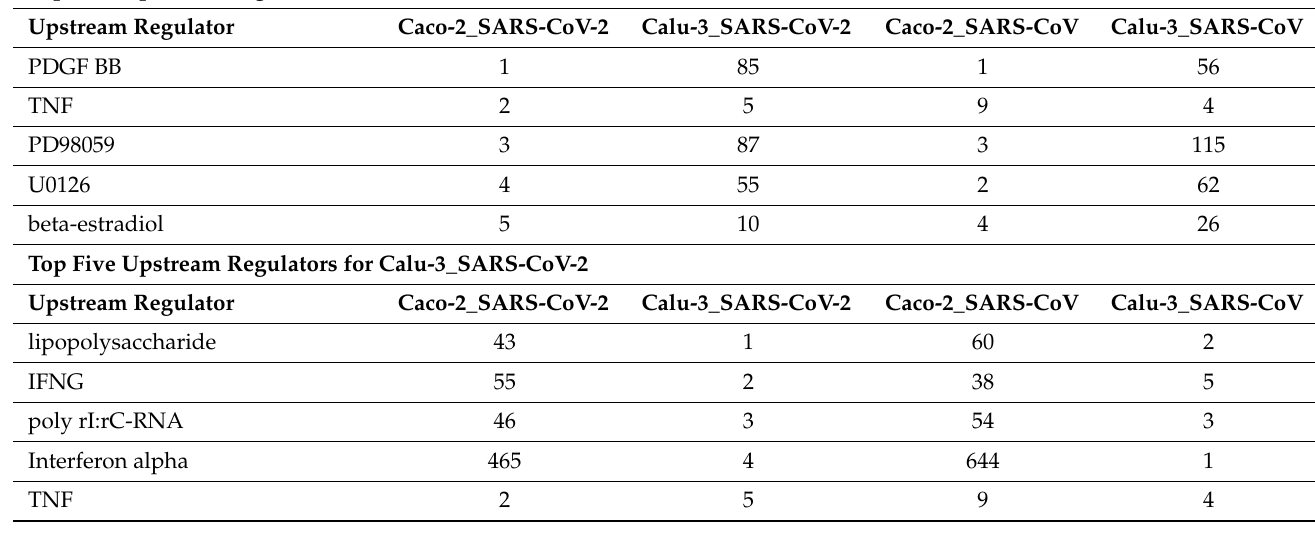
Table 2. The top five Upstream Regulators and the overlap among the conditions. The top five Up- stream Regulators for the conditions “Caco-2_SARS-CoV-2”, “Calu-3_SARS-CoV-2”, “Caco-2_SARS- CoV”, and “Calu-3_SARS-CoV-2” are given. For each condition, the top five Upstream Regulators are compared with those in the remaining three conditions; the position in the corresponding list for the indicated condition is given. Only statistically significant Upstream Regulators are included into the